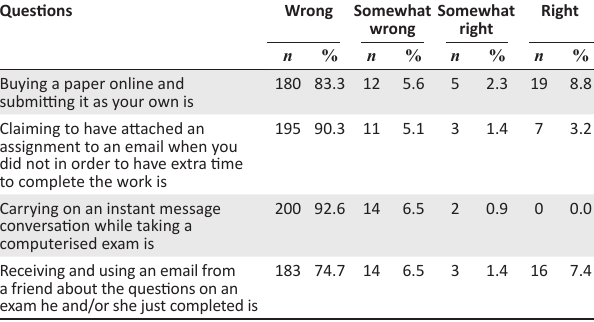
TABLE 3: Cheating category.